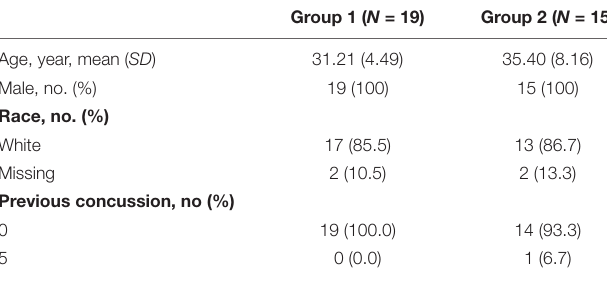
TABLE 1 | Sample characteristics of the study